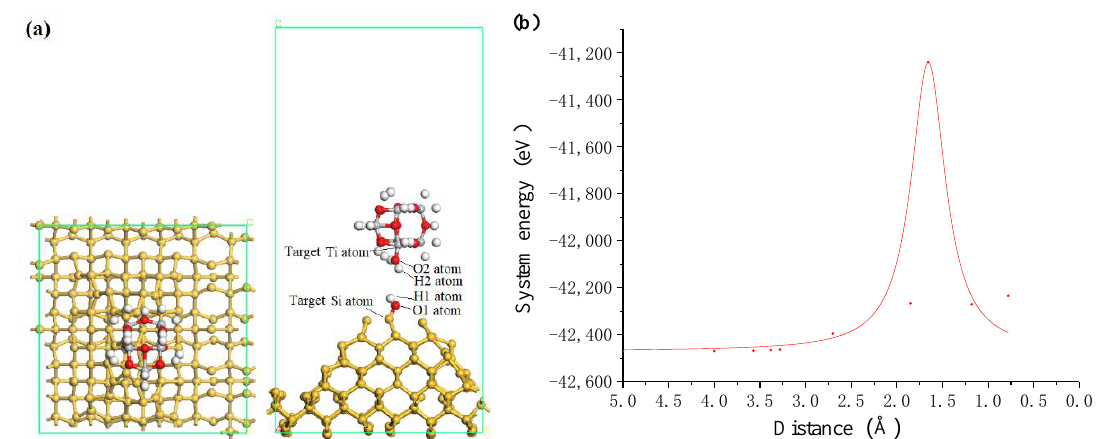
Figure 7. The incident impacting TiO 2 cluster approaching to silicon surface. ( a ) Schematic diagram of incident state where white, red, grey and yellow balls are hydrogen, oxygen, titanium and silicon atoms, respectively; ( b ) system energy with the distance between TiO 2 cluster and silicon surface.